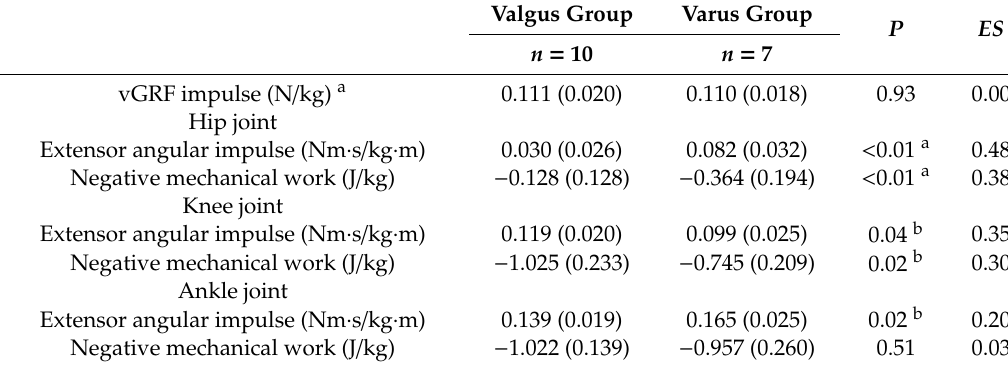
Table 1. The vGRF impulse, joint angular impulse, and mechanical work of the lower extremities (mean ± standard deviation) by the valgus and varus knee positions.